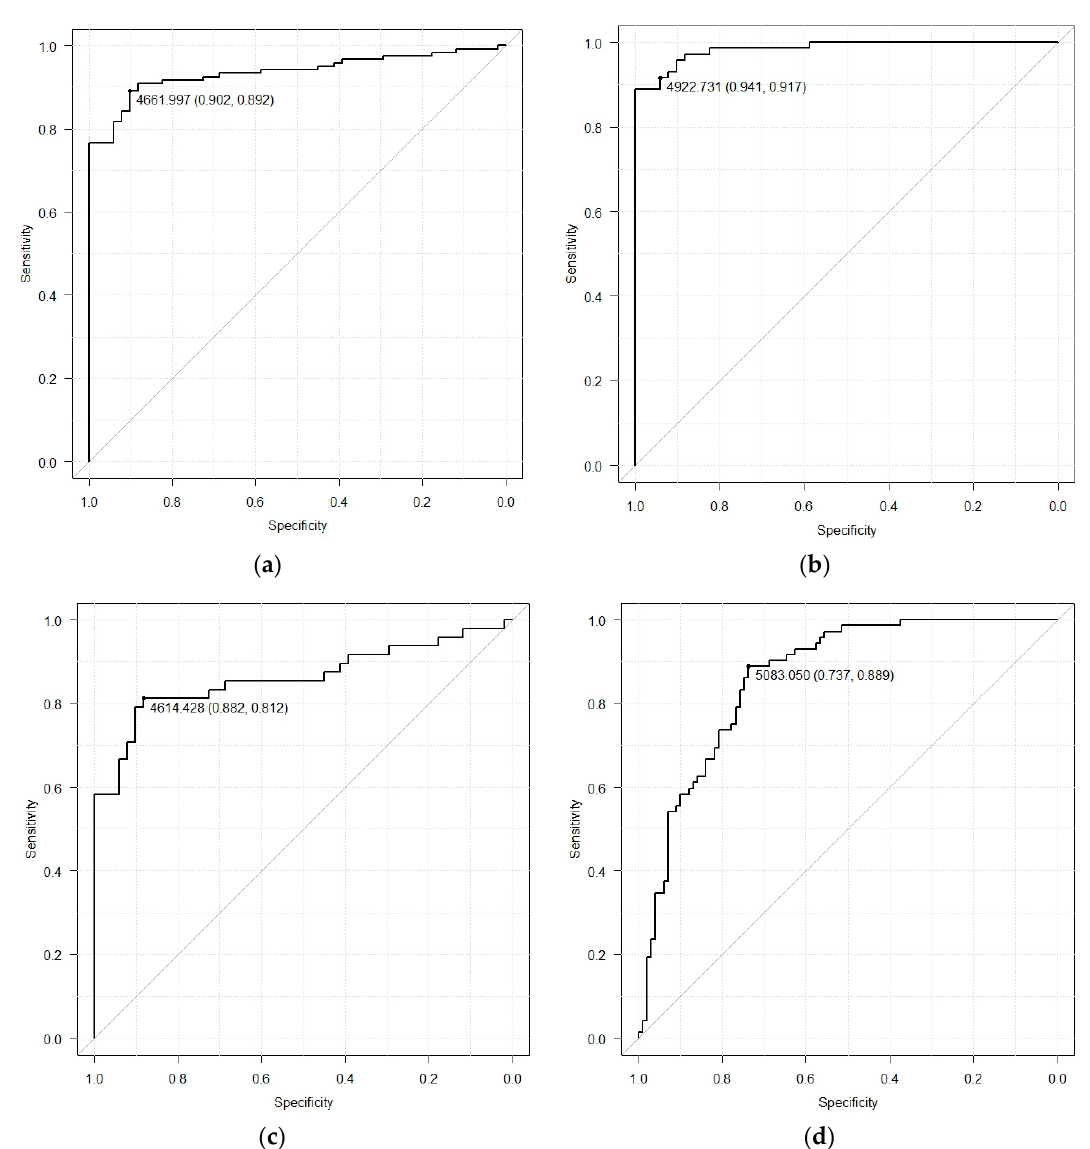
Figure 3. Receiver operating characteristic (ROC) curve. ( a ) ROC curve of normal vs. benign + malignant, ( b ) ROC curve of normal vs. malignant ( c ) ROC curve of normal + benign vs. malignant; and ( d ) ROC curve of benign vs. malignant.